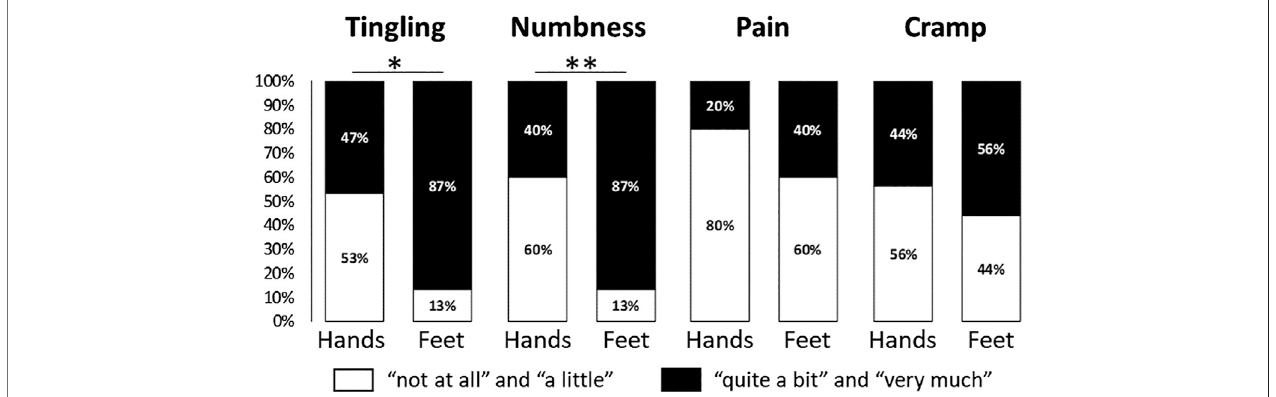
FIGURE3| SeverityproportionsoftheQLQ-CIPN20 itemsassessing tingling,numbness,pain andcramp inhandsandfeet, amongpatientswithasensoryCIPN. The response categories were recoded to yield a dichotomous outcome per item (white: “ not at all ” and “ a little ” vs. black: “ quite a bit ” and “ very much ” ). * p < 0.05, ** p < 0.01. Statistical analysis was performed using McNemar test for paired proportions.